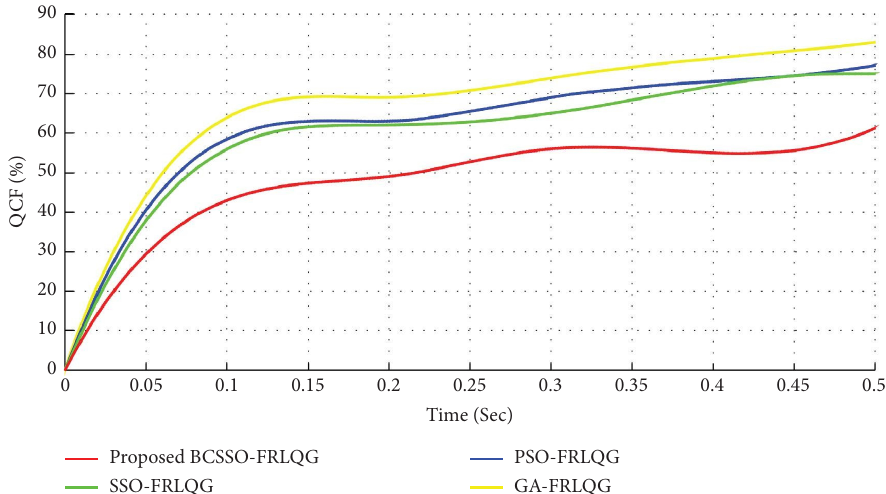
Figure 9: Comparison analysis of tuned controllers based on the QCF metric.